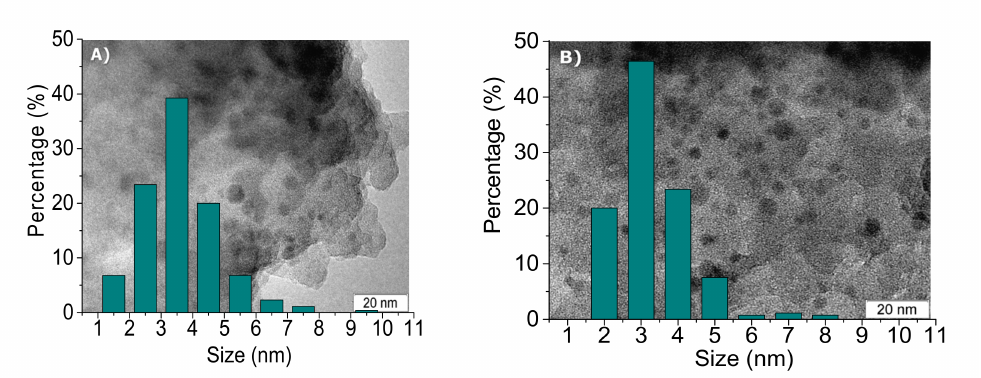
Figure 2. Transmission electron microscopy (TEM) micrographs and particles size distribution of Ni 2 P/SiO 2 catalysts obtained by ex situ reduction ( A ) and by in situ reduction and exposed to the catalytic reaction ( B ).